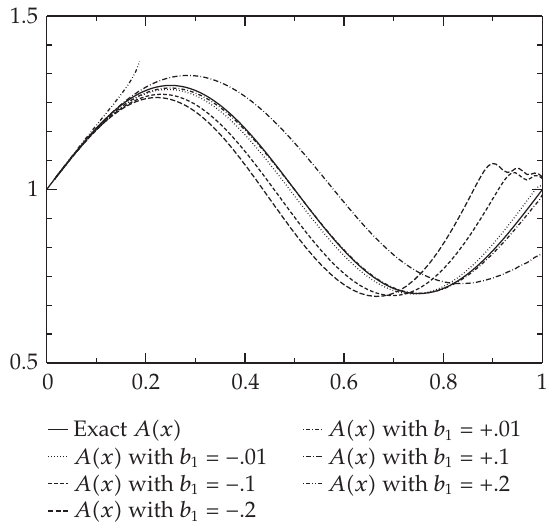
Figure 7.3 . The reconstructed cross-sectional area A ( x ) = 1 + . 3sin ( 2 πx ) for various b 1 values using n = 128 grid